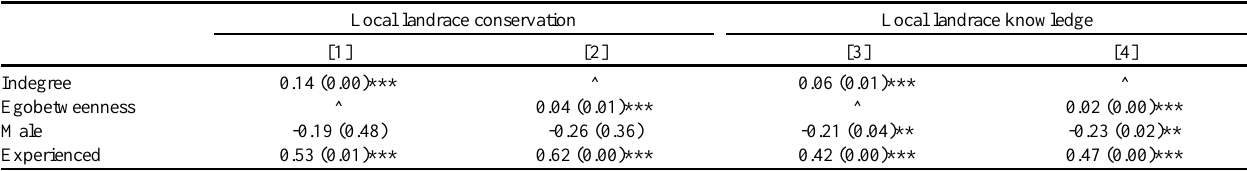
Table 4 . Poisson multivariable regressions between individual centrality in the network of seed exchange (indegree and egobetweenness) and local landrace conservation and knowledge (outcome) ( n = 55). The regressions are Poisson with the standard error (in parentheses). Regressions include clusters depending on the village of residence and constant (not shown). For definition of variables see Table